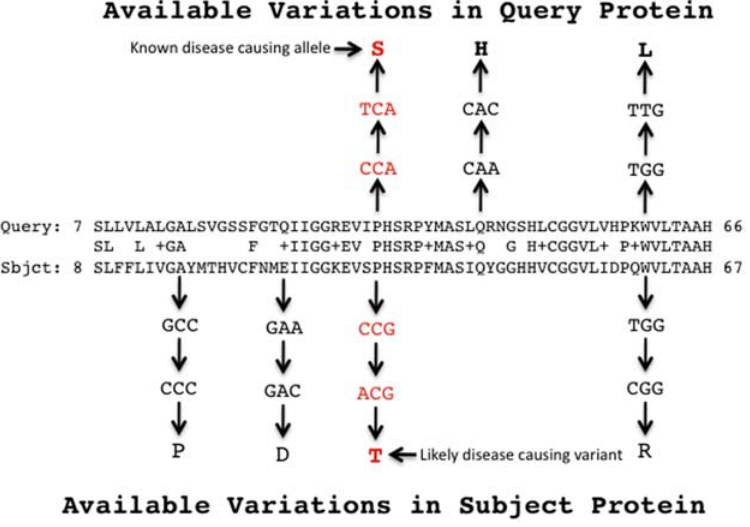
Figure 1. Using sequence homology to identify variant pairs. The protein encoded by a candidate disease gene (the subject in the alignment) is aligned to a paralogous protein encoded by a locus with known disease-causing alleles (the query in the above alignment). Shown in red is a paralogous variant pair. Variants in the candidate that occur in the same positions in the alignment as a known disease-causing variant in the other protein are prioritized for use in subsequent association studies.